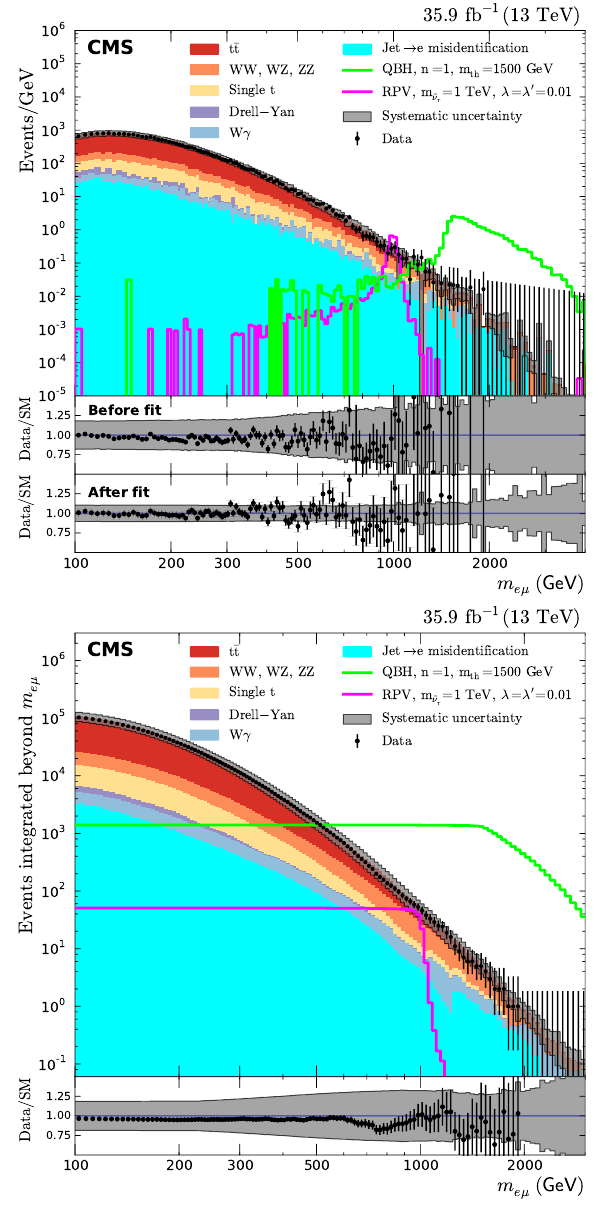
Figure 2 . Upper: the invariant mass distribution for selected e (cid:22) pairs in data (black points with error bars), and stacked histograms representing expectations from SM processes before the (cid:12)t. Also shown are the expectations for two possible signals. The two lower panels show the ratio of data to background expectations before and after the (cid:12)t. The total systematic uncertainties are given by the gray bands. Lower: the cumulative (integral) distribution in events integrated beyond the chosen m e (cid:22) . The lower panel shows the ratio of data to background predictions before the (cid:12)t. Some events in the invariant mass distribution can have a negative event weight and result in a rise of the cumulative mass distribution. In both (cid:12)gures the label (cid:21) refers to (cid:21) 132 = (cid:21) 231 , while (cid:21) 0 stands for (cid:21) 0 . 311